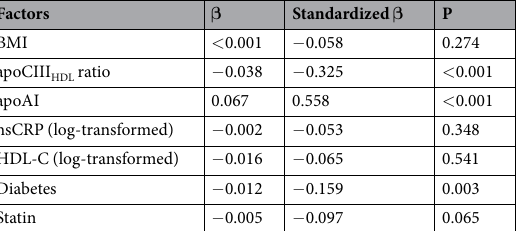
Table 6. Stepwise multiple regression analysis detecting independent contributors to HDL-mediated cholesterol efflux capacity in all the subjects. BMI indicates body mass index; apoCIII HDL